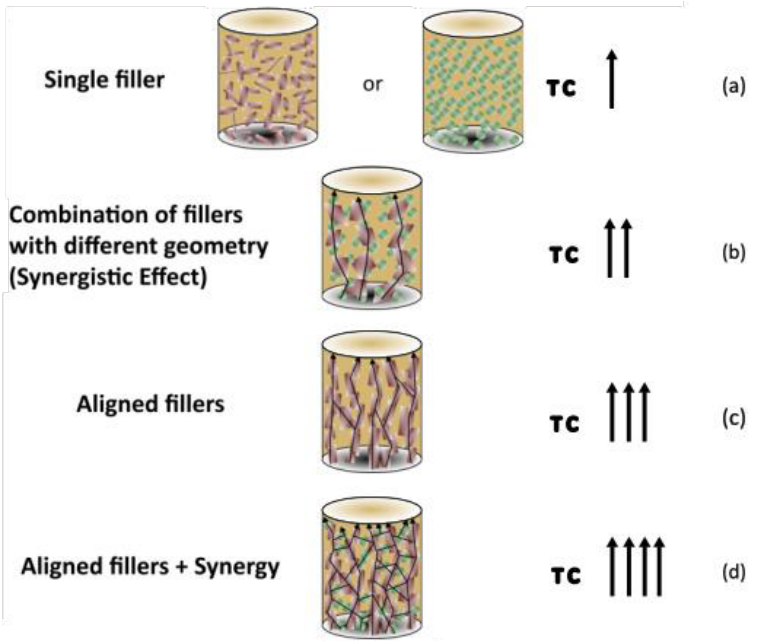
Figure 2. Thermally conductive pathway formation due to filler alignment and synergistic effect between platelet (red) and spherical (green) shaped particles. The TC increases from ( a ) to ( d ): ( a ) Single filler (spherical or platelet-shape) system with relatively low TC, ( b ) Synergistic effect of a combination of platelet and spherical-shape fillers with higher TC, ( c ) Aligned, platelet-shape fillers with higher TC, ( d ) Combination of synergistic effect of the different shape fillers and alignment of platelets in a system with very high TC.